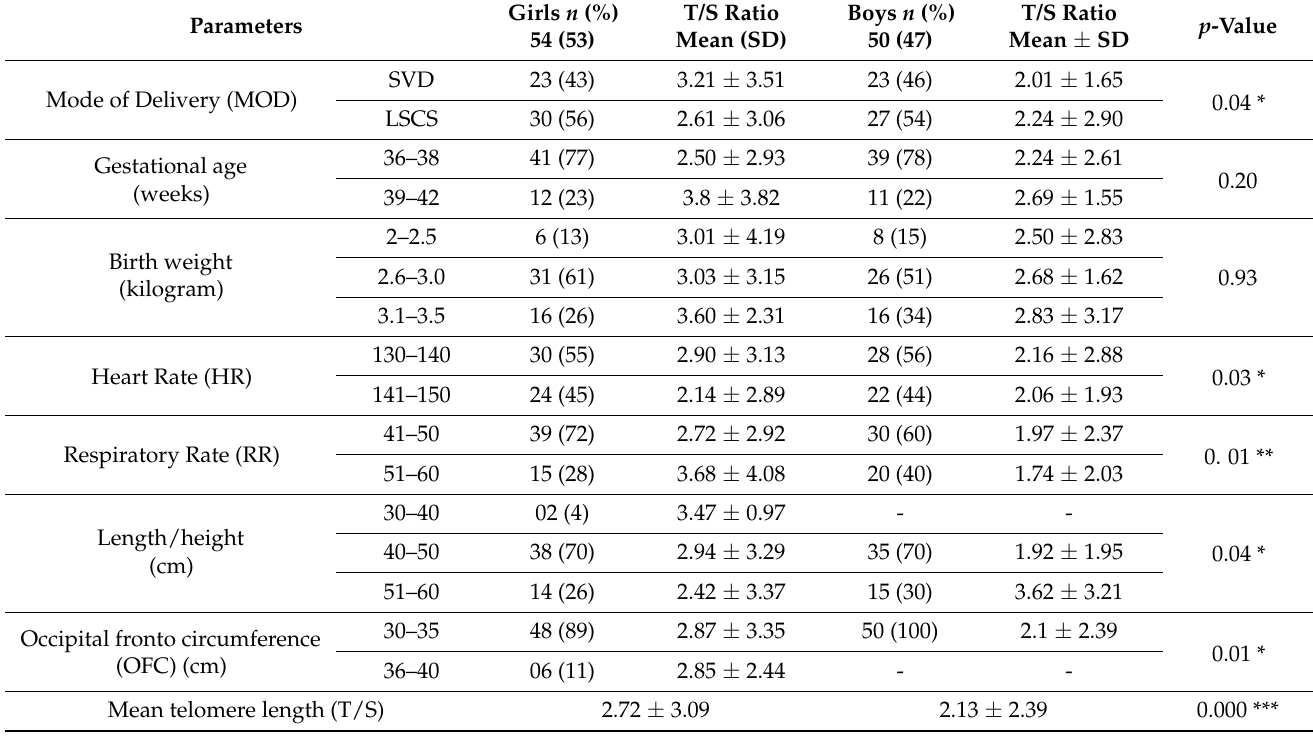
Table 3. Difference between telomere length (TL) among newborn gender.